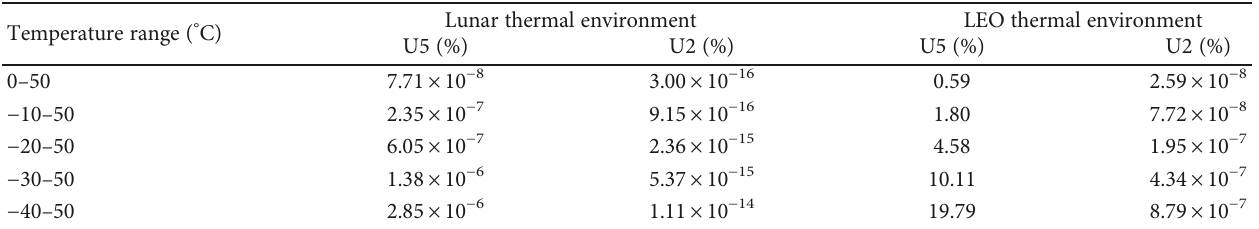
Table 8: Summary of predicted mechanical reliability of U5 and U2 solder joints under lunar and LEO thermal environments. Temperature range ( °